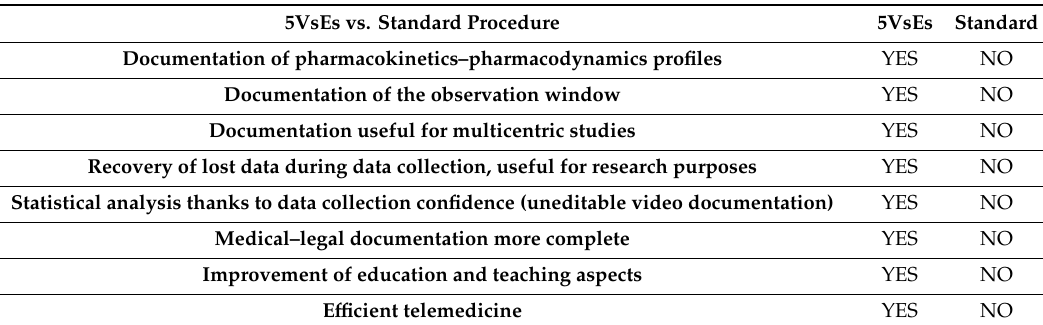
Table 3. 5VsEs vs. standard technology